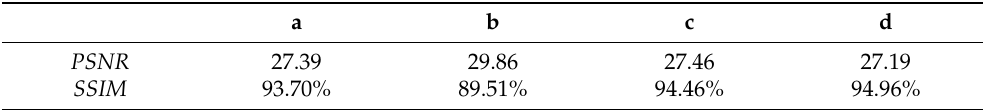
Table 1. Effect of Denoise.